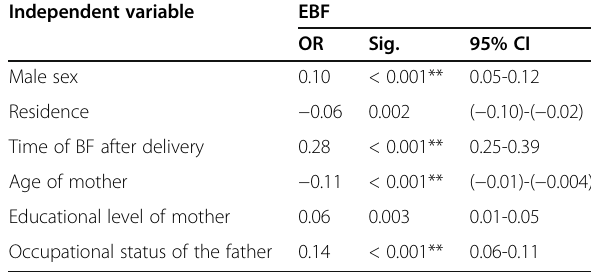
Table 4 Predictors for appropriate exclusive